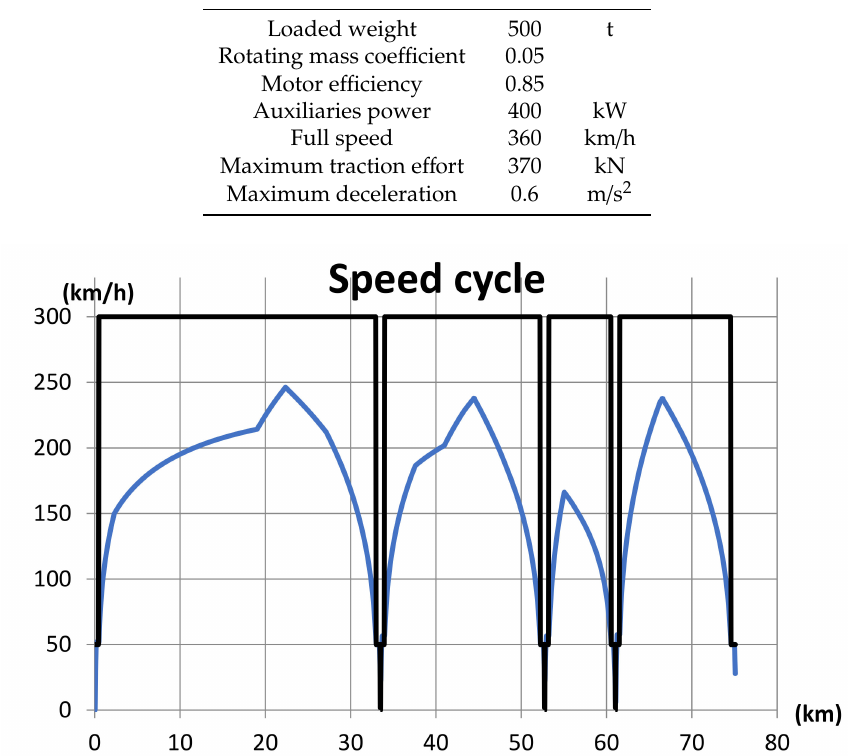
Figure 7. Speed cycle of the